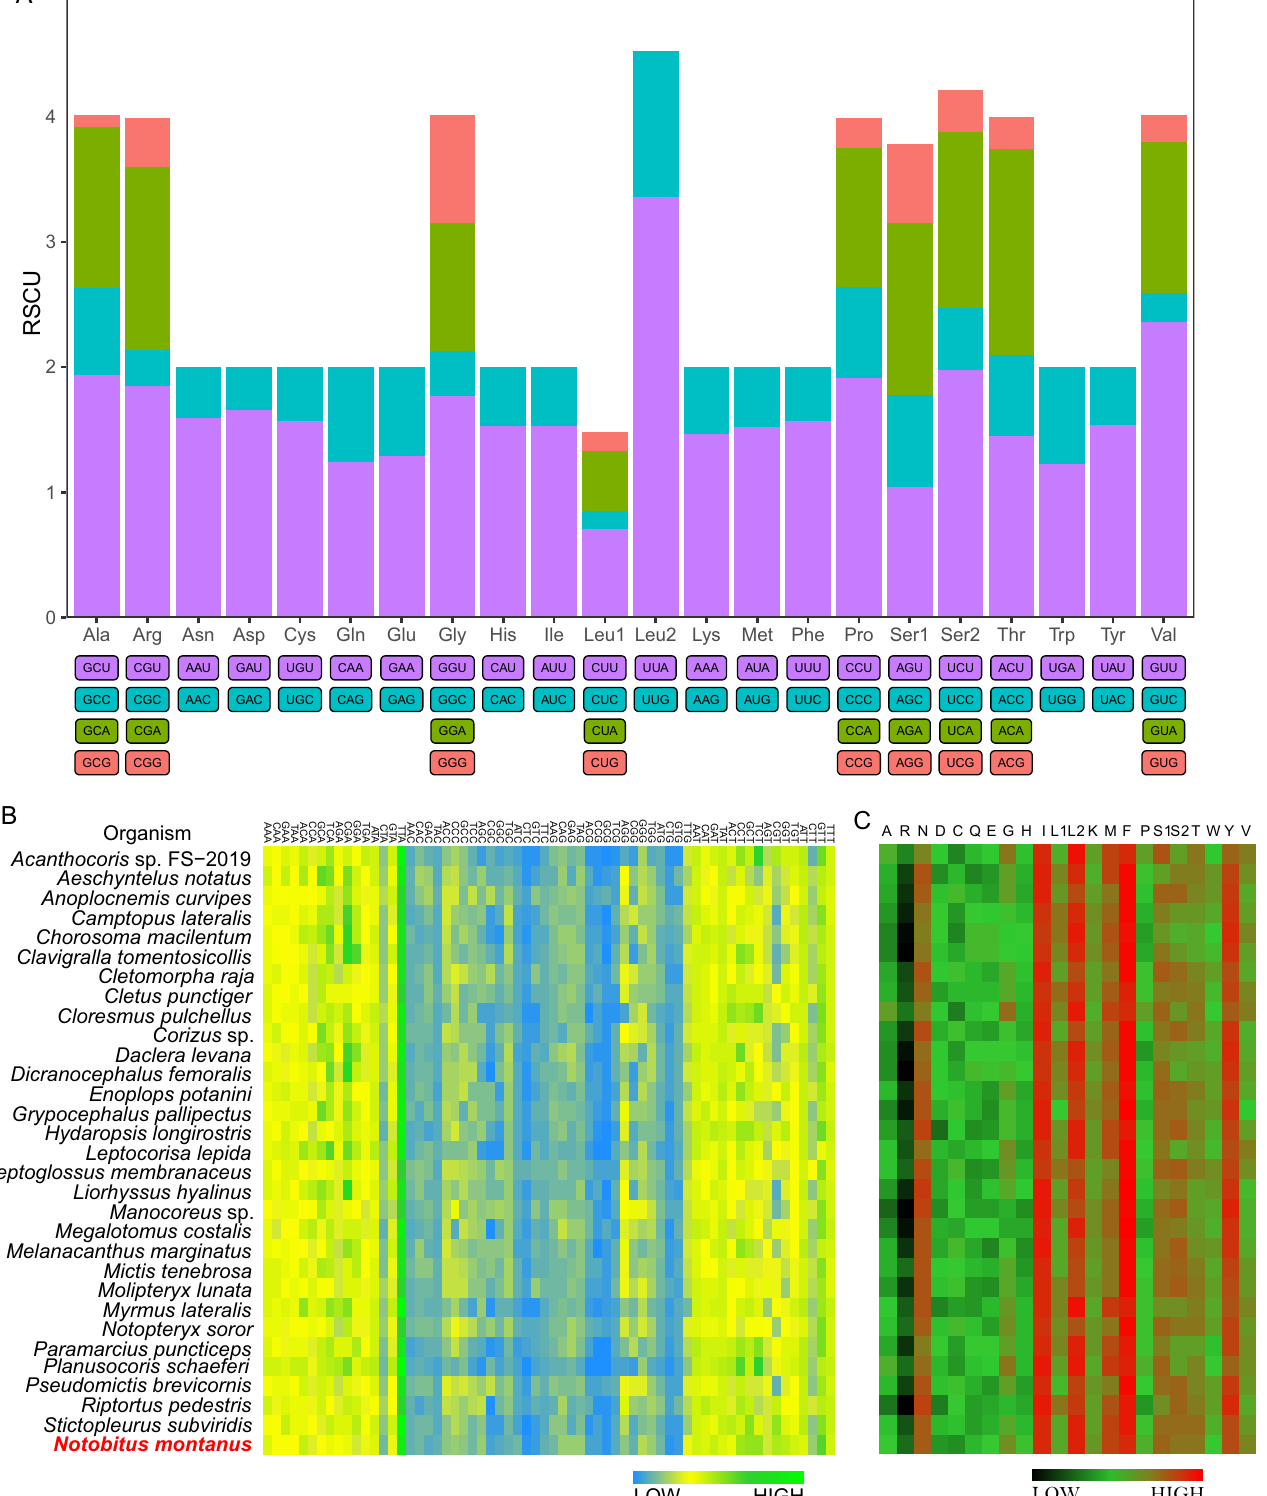
Fig 2. Codon and amino acid usage. (A) Relative synonymous codon usage (RSCU) of N . montanus . (B) Heatmap indicates codon usage in 31 Coreoidea species. (C) Heatmap indicates amino acid usage in 31 Coreoidea species.